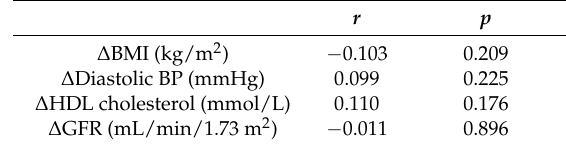
∆ = (variable after PCI − variable before PCI)/variable before PCI), BMI = body mass index, BP = blood pressure, eGFR = estimated glomerular filtration rate, HDL = high-density lipoprotein, PCI = percutaneous